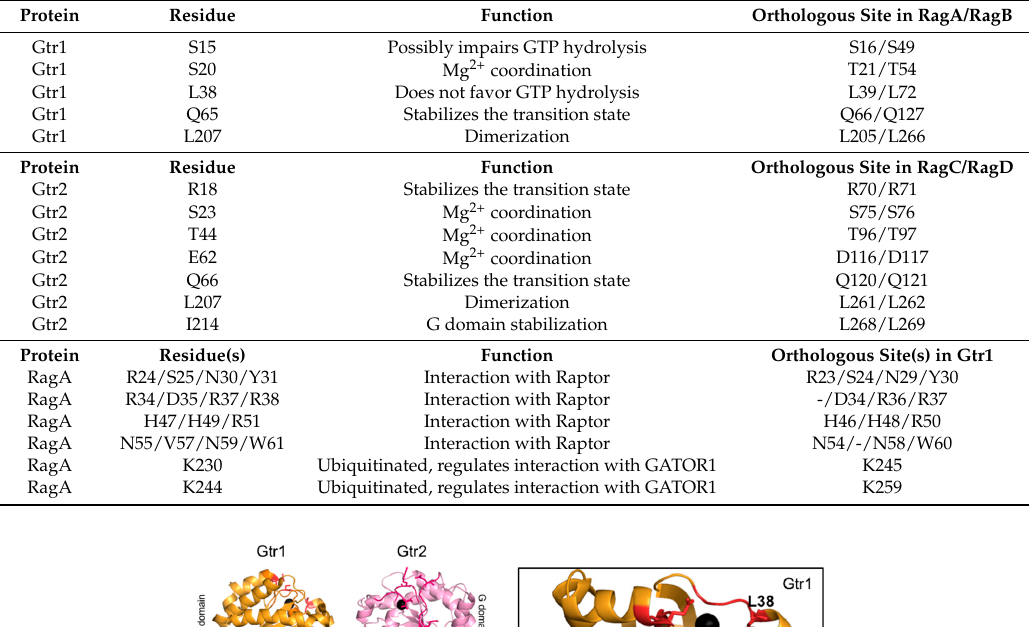
Table 1. Important residues in Rag GTPases.